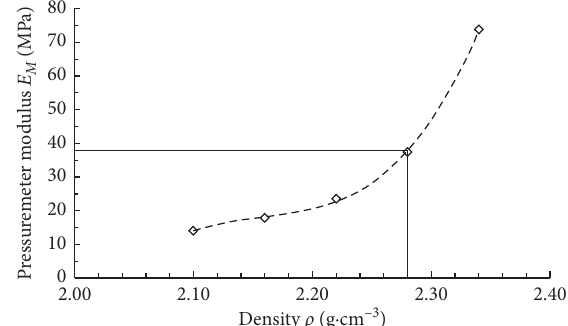
Figure 2: Prediction of in situ density based on pressuremeter model